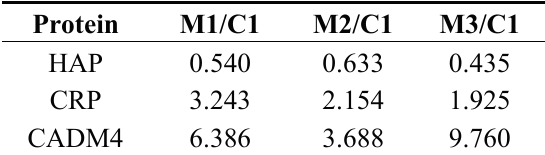
Table 1. Isobaric tags for relative and absolute quantitation (iTRAQ) ratios for selected serum proteins in malaria-infected patients ( P. knowlesi , P. falciparum and P. vivax ) relative to uninfected